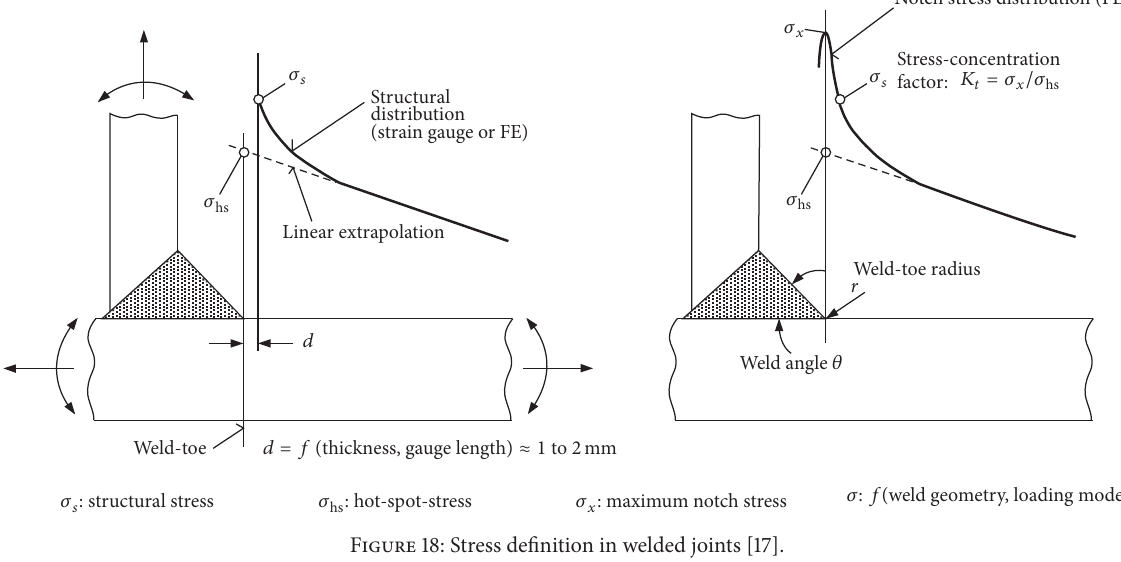
Figure 18: Stress definition in welded joints [17].